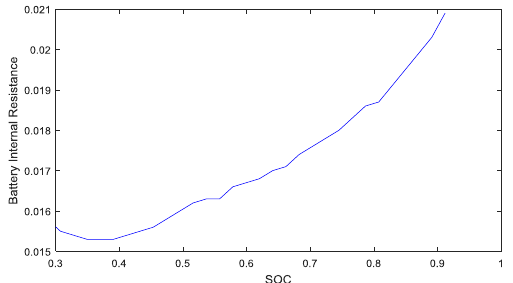
Figure 9. Relation between battery SOC and internal resistance during battery charge.